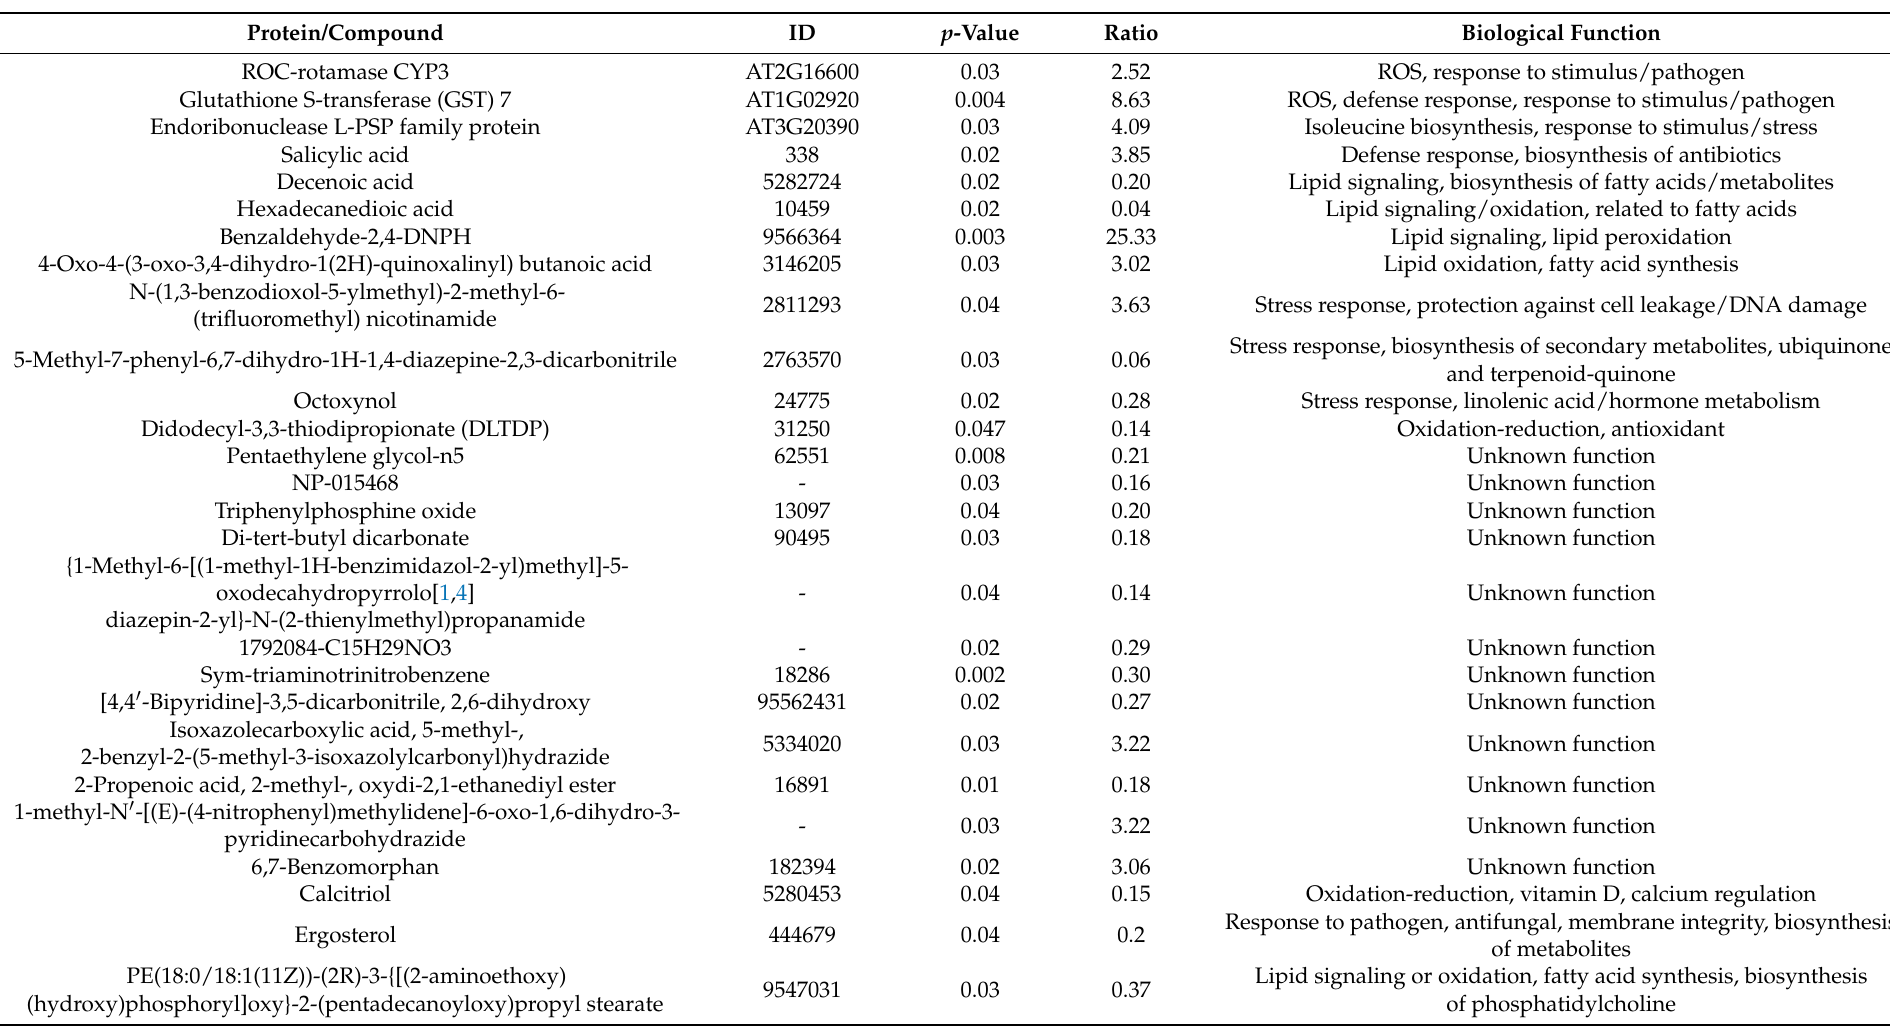
Table 1. List of proteins (top), metabolites (middle), and lipids (bottom) with more than two-fold changes in guard cells after systemic acquired resistance (SAR) priming. (The protein IDs are from TAIR database and the compound IDs are from PubChem. The ratios are